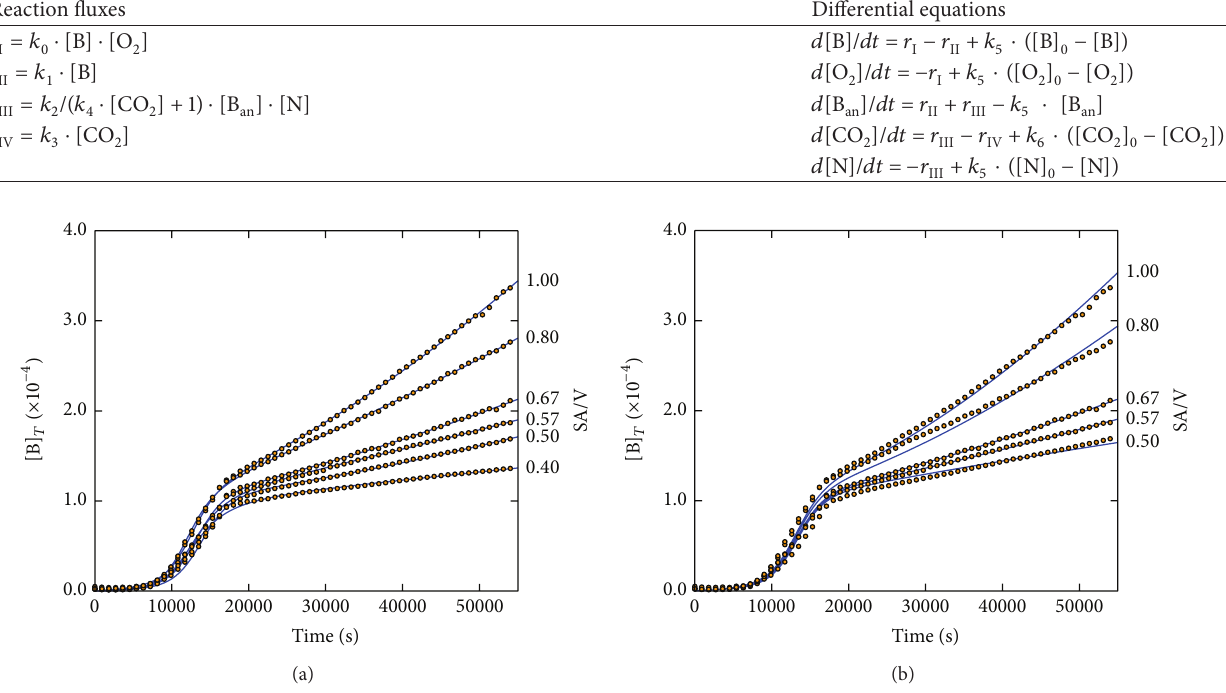
Figure 2: Series of EPEC growth experiments with SA = 1.0 cm 2 and V = 1.0 to 2.5 cm 3 corresponding to SA/V = 0.4 to 1.0 cm −1 (open circles) best fitted by the CKA model (solid lines). (a) Fitting of each growth curve independently with obtained values for 𝑘 0 to 𝑘 4 according to Table 2. (b) Only fitting of 𝑘 3 at fixed 𝑘 0 = 6.46 M −1 s −1 , 𝑘 1 = 5.99 × 10 −5 s −1 , 𝑘 2 = 2.18 × 10 −1 M −1 s −1 , and 𝑘 4 = 4.18 × 10 8 M −1 . Obtained values for 𝑘 3 at different (SA/V): 1.29 × 10 −5 (0.50), 6.18 × 10 −5 (0.57), 1.07 × 10 −4 (0.67), 2.97 × 10 −4 (0.80), and 4.53 × 10 −4 (1.00) s −1 . Initial